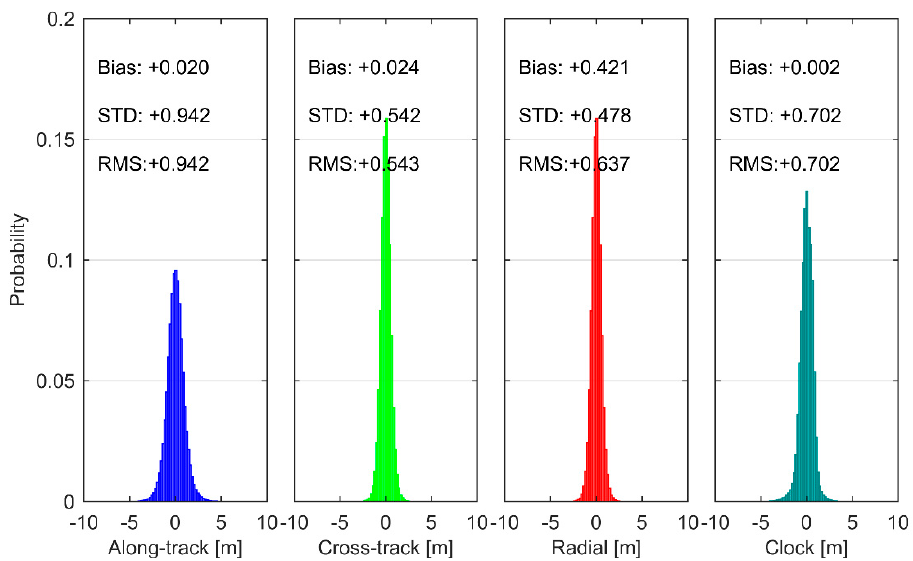
Figure 12. The distribution of orbit and clock errors for Global Positioning System (GPS) broadcast navigation data.